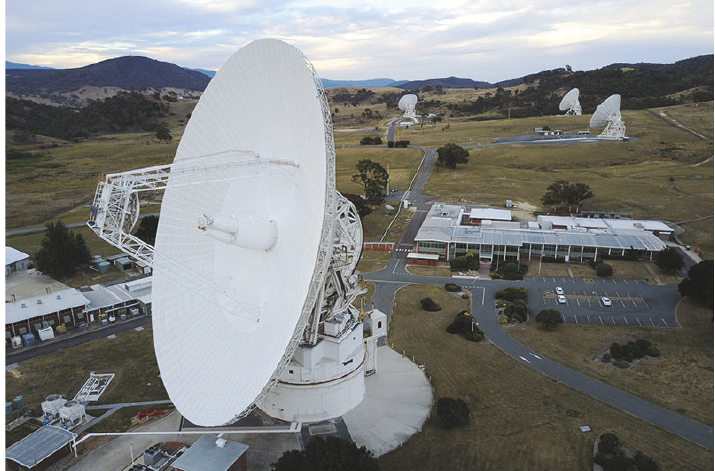
Figure 3: Image of the Canberra Deep Space Communication Complex (CDSCC). The 70 m telescope (DSS-43) is shown in the foreground, and the three 34 m beam waveguide antennas (DSS-34, DSS-35, and DSS-36) are shown in the background. Image credit: CDSCC (see https://www.cdscc.nasa.gov/Pages/antennas.html).